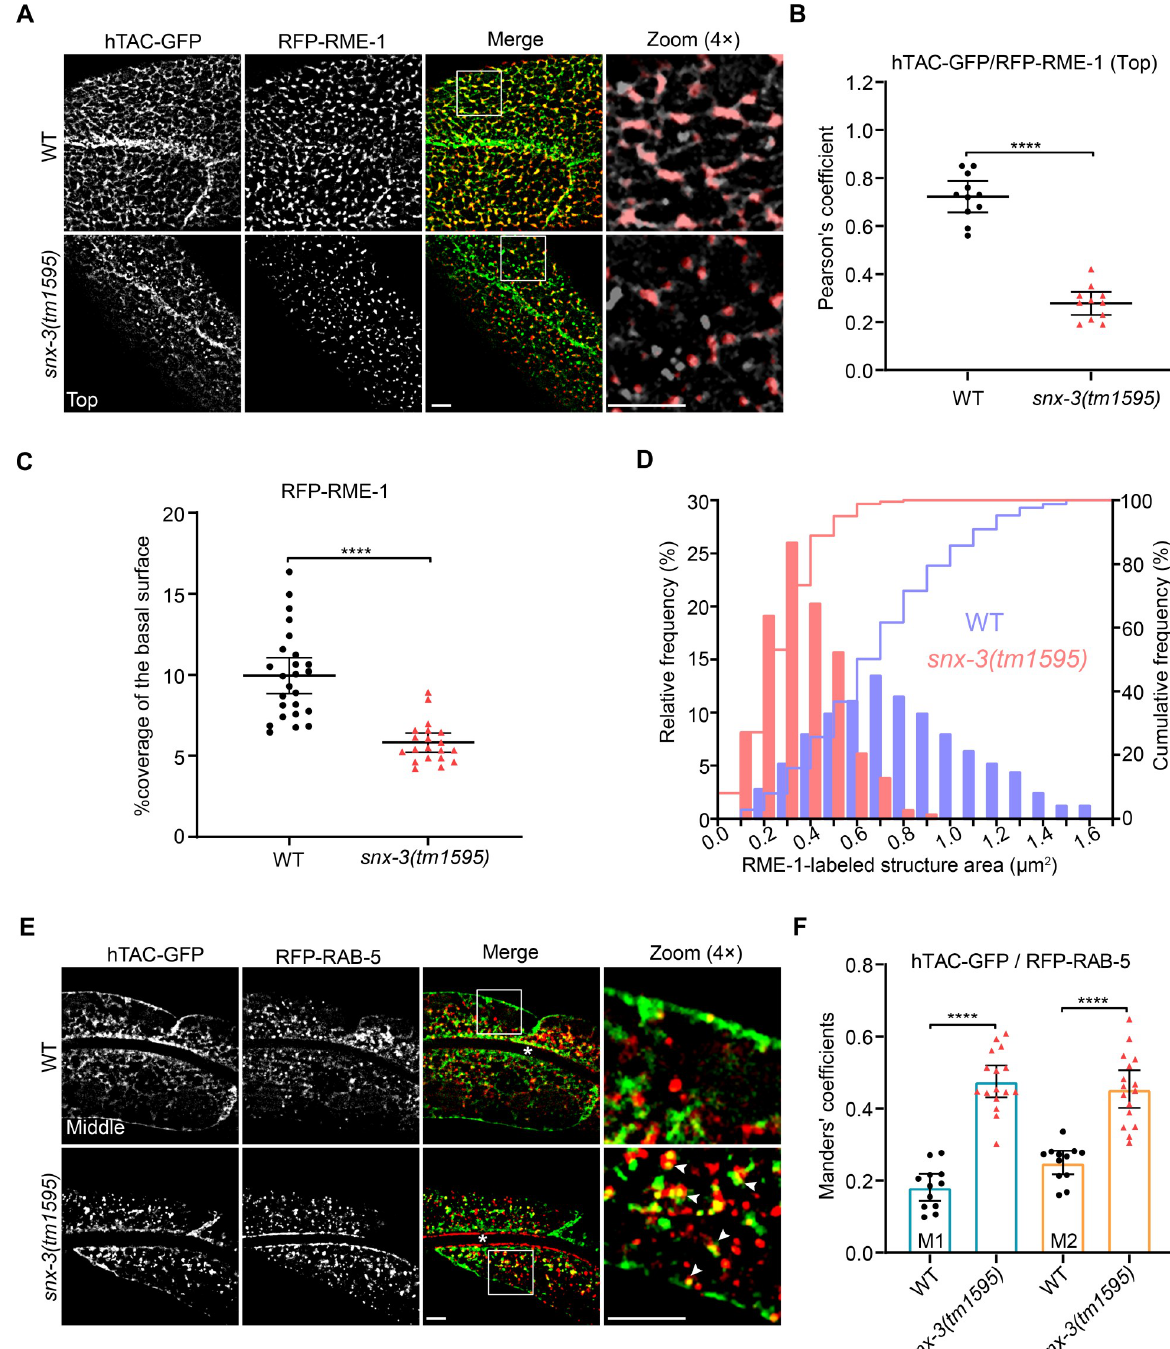
Fig 2. Loss of SNX-3 leads to misrouting of hTAC away from the recycling pathway. (A) Micrographs taken with a 150 × objective showing the detailed architecture and location of RFP-RME-1-labeled basolateral recycling endosomes with respect to hTAC-GFP-containing carriers. In snx-3 (tm1595) mutants, the rod-like profiles of RFP-RME-1 prominently changed to spherical ones and shrank in size. (B) Quantification of the Pearson’s correlation coefficients for hTAC-GFP and RFP-RME-1 signals as depicted in A, error bars are mean ± 95% CI ([ROI] = 11, n = 11). ���� P < 0.0001 (Student’s t test). (C) Coverage percentage of the basal surface by RFP-RME-1, as the magnified regions shown in A, was quantified. WT: [ROI] = 25, n = 6; snx-3(tm1595) : [ROI] = 20, n = 5. Error bars are mean ± 95% CI. ���� P < 0.0001 ( t test with Welch’s correction). (D) Effect of loss of SNX-3 on the size of RME-1-labeled structures. Histogram and cumulative distributions showed prominent decrease in the areas of RFP-RME-1 structures in snx-3(tm1595) mutants, analyzed for 253/262 RME-1-positive structures from 6/5 animals (WT/ snx-3(tm1595) ). (E) Confocal images showing colocalization between hTAC-GFP and EEs labeled by RFP-RAB-5. Compared with the WT animals, the overlap level of